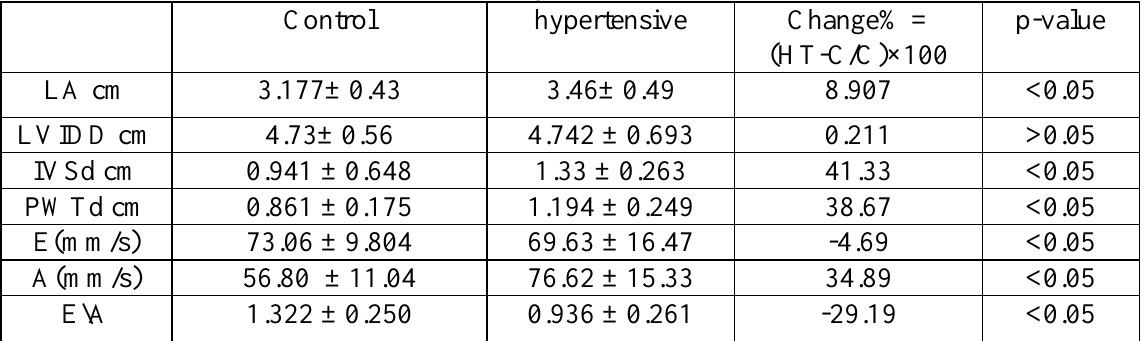
Table 1: Conventional M mode and two dimensional echocardiographic findings, ages from 20-80